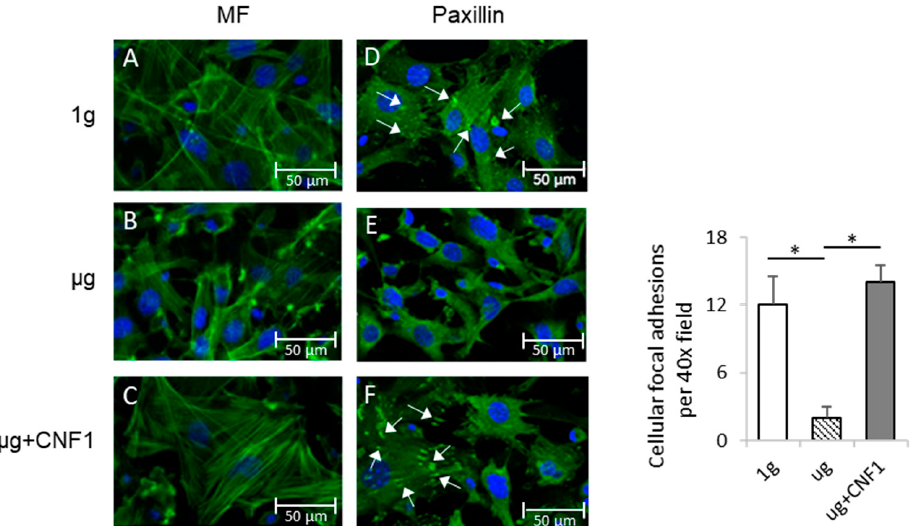
Figure 1. Measurement of cytoskeleton structures and focal adhesions of MC3T3-E1 cells cultured under different conditions. MC3T3-E1 cells were cultured in chamber slides under 1 g ( A , D ), µ g ( B , E ) and µ g + CNF1 ( C , F ). The cells on slides were stained with ( A – C ) FITC-phalloidin (green) and ( D – F ) anti-paxillin antibody (green). Slides were then covered with cover slips using Prolong Gold Antifade Reagent with DAPI (blue) and analyzed for microfilament (green) and focal adhesions (green), respectively, by fluorescence microscopy using 40 × objectives (formation of cellular focal adhesions, white arrows). The average numbers of cellular focal adhesions per 40 × field were measured by using ImageJ software. Data represent the mean ± SD. * p < 0.05 versus different groups by using Student t test. One representative experiment of two is shown.